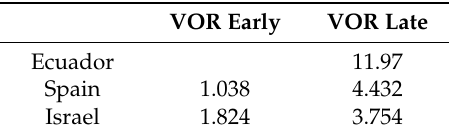
Table 5. Values of Reliability at each location.